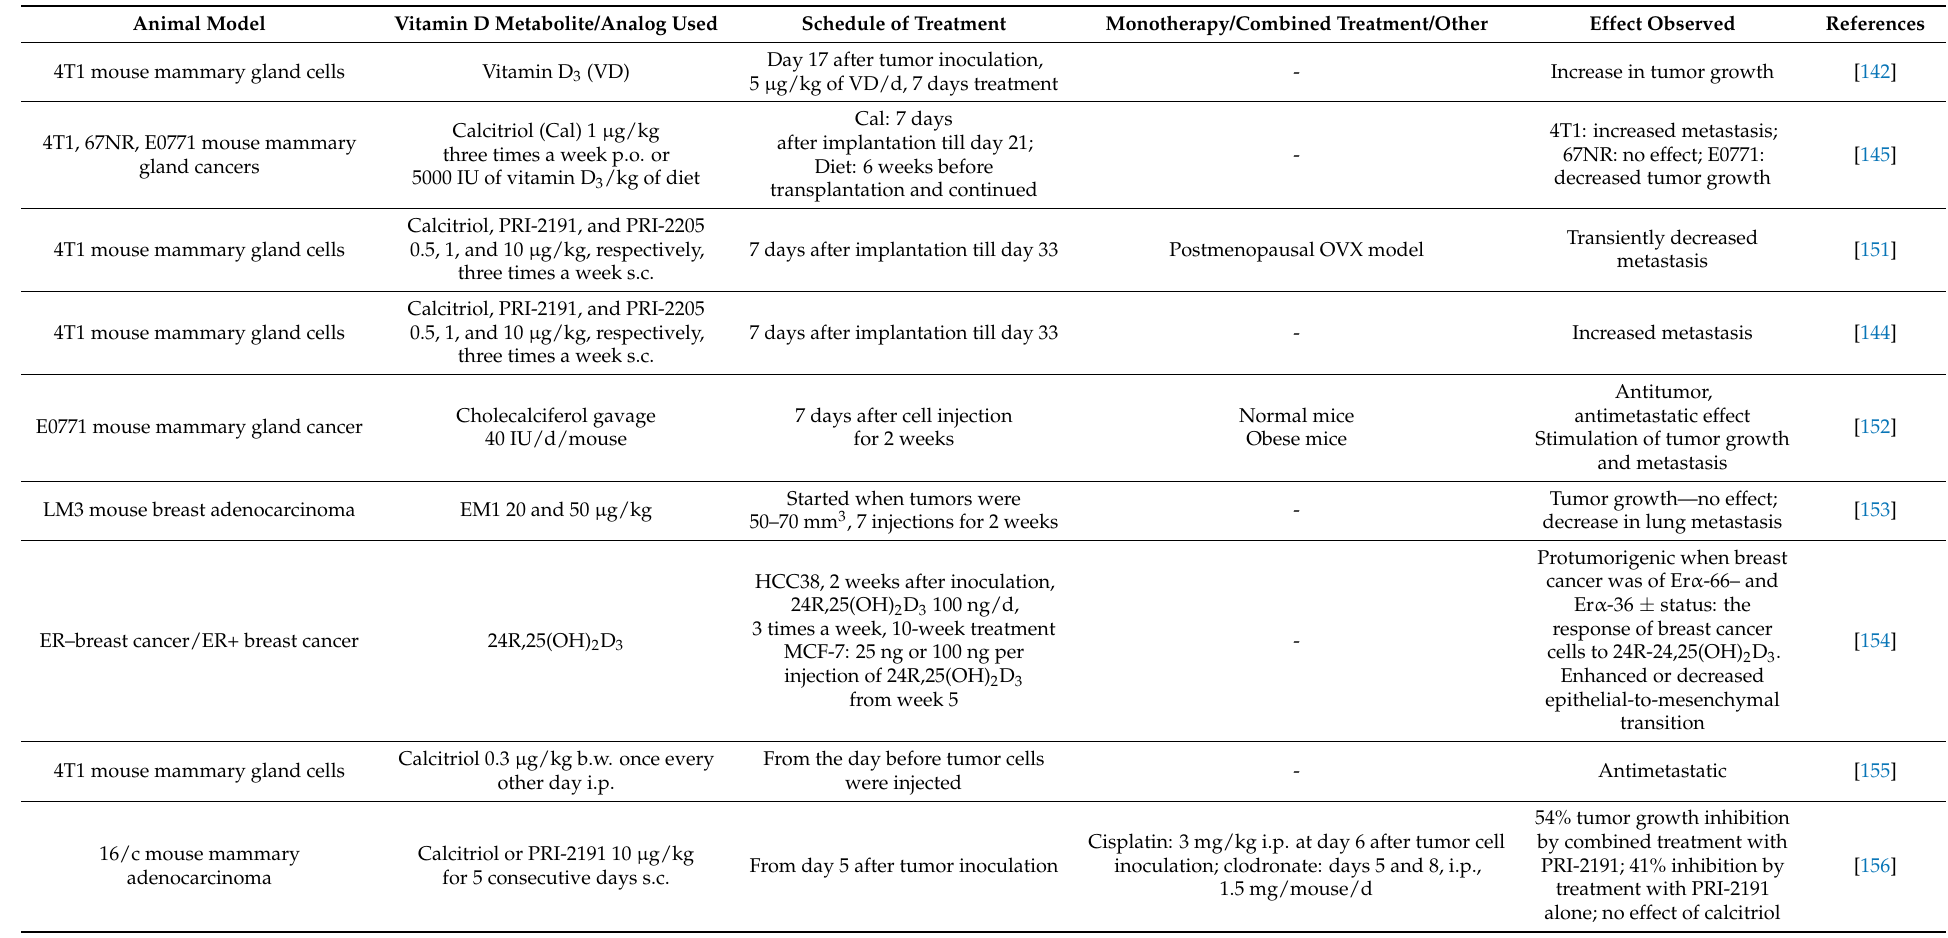
Table 3. Summary of animal experiments in breast cancer models with the use of vitamin D, calcitriol, or its analogs, alone or combined with anticancer